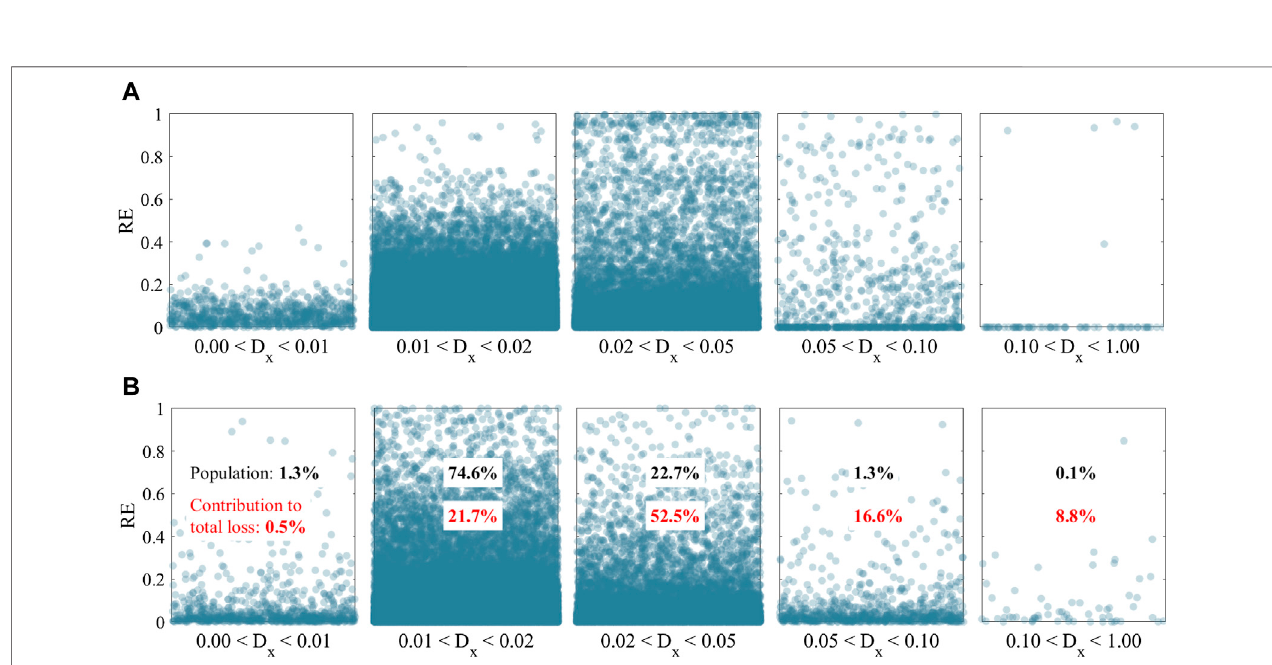
FIGURE 7 | Visualization of the predictive behavior of the RD-GSx method based on the distance of datapoints from the center of the input domain. Datapoints in each bin are distributed randomly along the x -axis. (A) Loss ratio label. (B) Safety tag label.